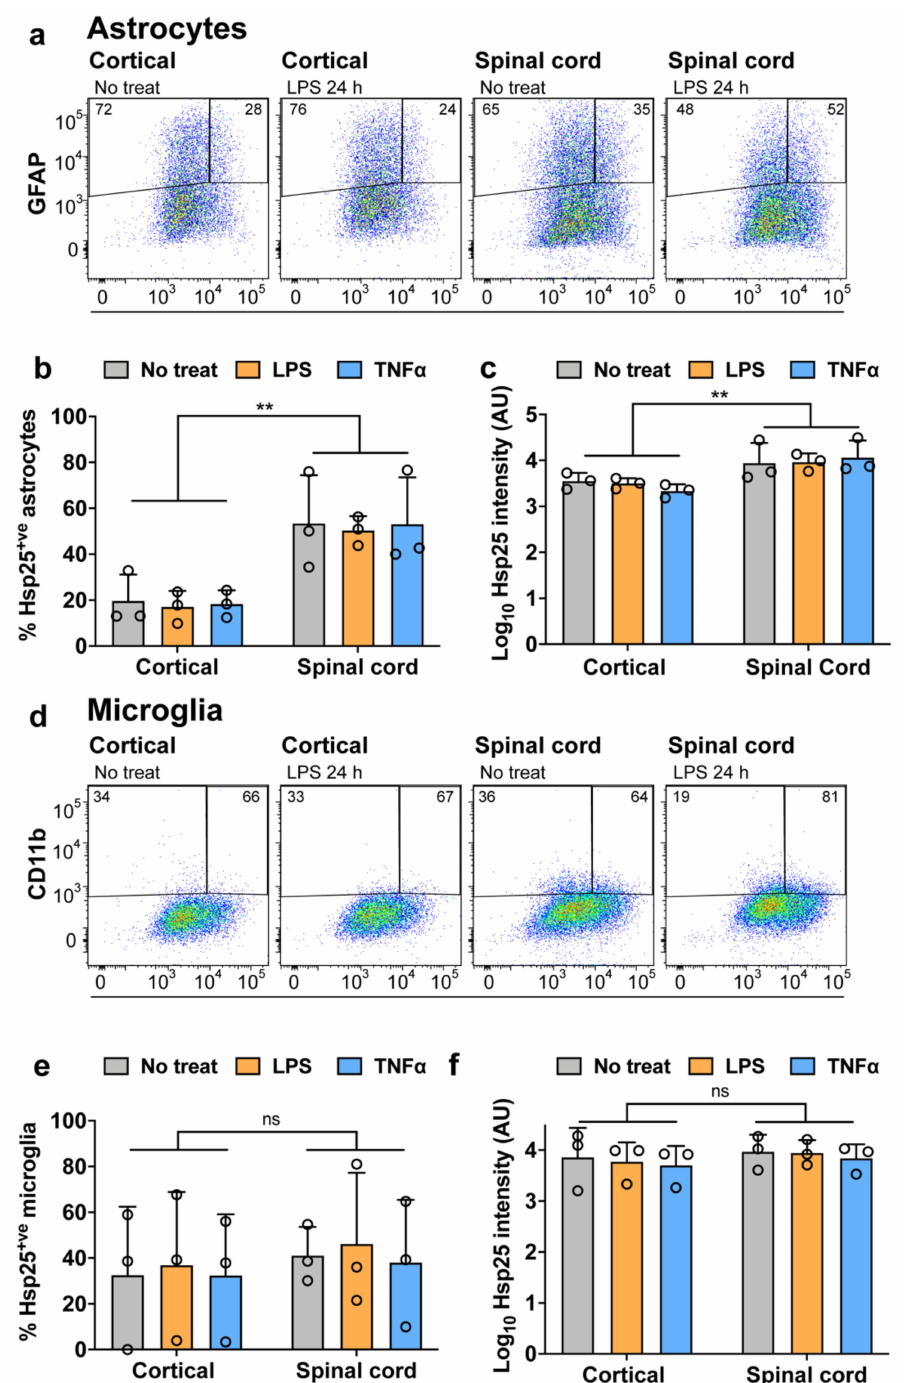
Figure 2. Flow cytometric analysis of Hsp25 expression in astrocytes and microglia after LPS and TNF α treatment. Primary cortical and spinal cord mixed glial cultures were treated with 80 µ g/mL LPS or 100 ng/mL TNF α . The cells were fixed, permeabilised and immunolabelled for GFAP-Cy3, CD11b-APC/Cy7 and Hsp25-AF488. ( a , d ) Flow cytometric analysis of cortical and spinal cord glial cultures. Left–right: Representative cytograms of untreated and LPS treated cortical glial cultures, and untreated and LPS treated spinal cord cultures. Data are presented as pseudo-colour scatter plots where blue represents low and red represents a high frequency of cells. The percent of GFAP +ve or CD11b +ve cells in each gate is provided. ( b , e ) The percent of Hsp25 +ve astrocytes or microglia as determined from the flow cytometric analysis. ( c , f ) The Hsp25-AF488 fluorescent median of the astrocytic or microglial population in arbitrary units (AU). Data shown are the means ± SEM of three biological replicates. Differences between the means were determined using a two-way ANOVA followed by Bonferroni’s post hoc test, where p < 0.01